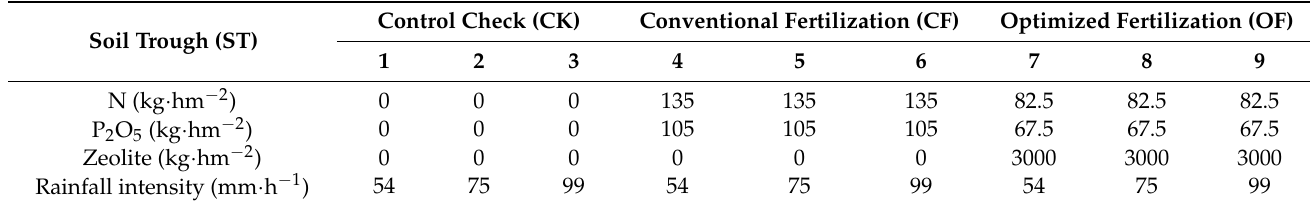
Table 1. Fertilization schemes and rainfall intensity of soil troughs in the experiments. Soil Trough